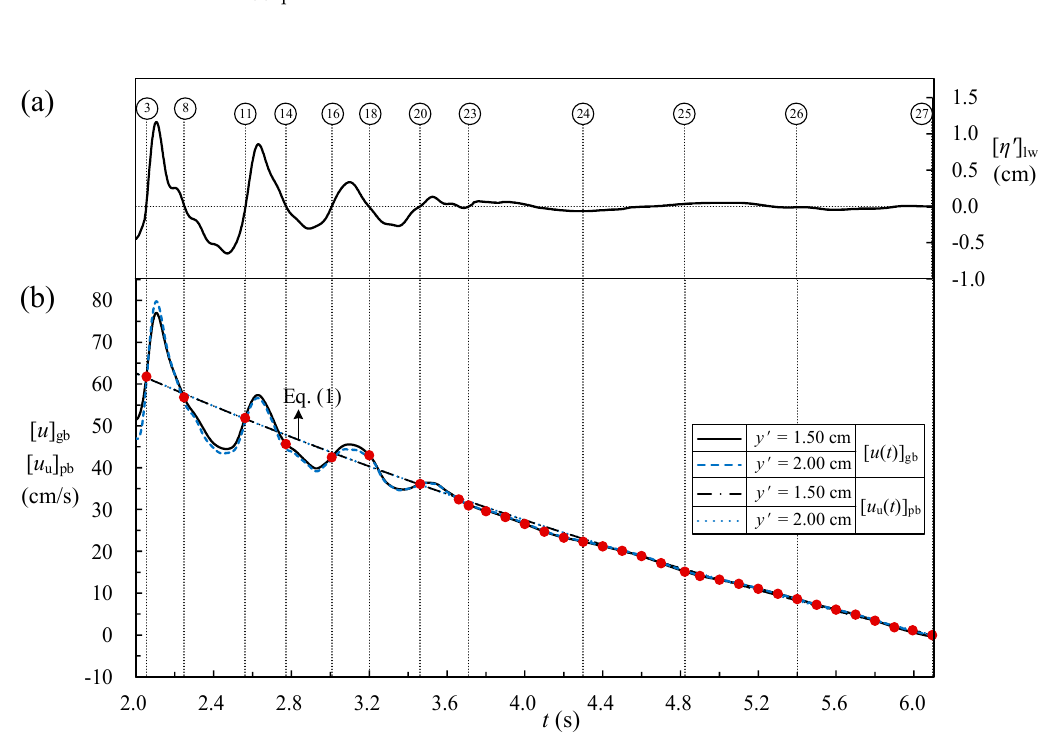
Figure 14. Time series of ( a ) [ η ′ ( t )] lw ; ( b ) [ u ( t )] gb and [ u u ( t )] pb for y ′ = 1.50 and 2.00 cm at SMS for 2.000 s ≤ t ≤ 6.094 s. Velocities [ u u ( t )] pb at both y ′ are almost identical and overlap together as shown in ( b ). Times varying from circled 3 to 27 are presented in sub-table of Figure 7a,b.